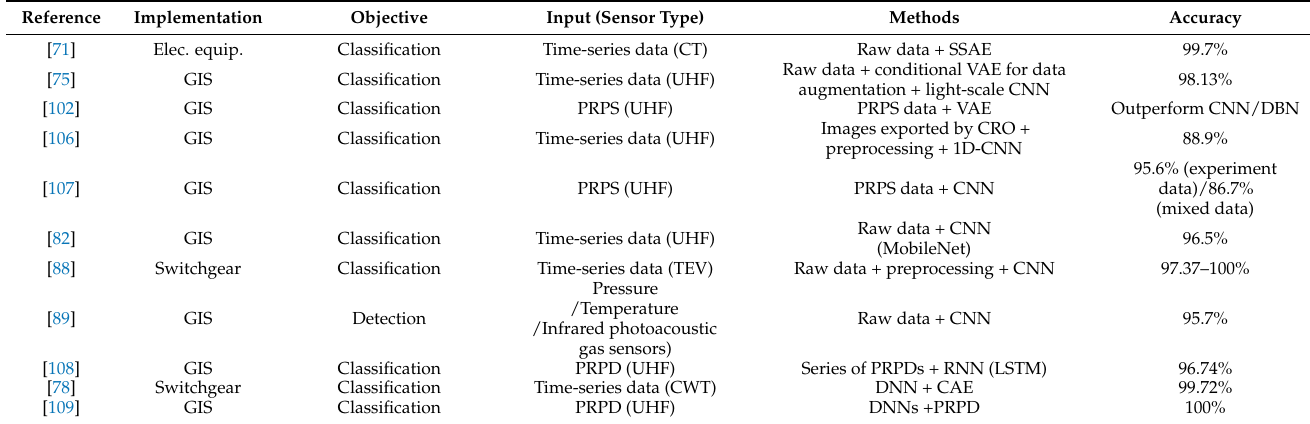
Table 5. Summary of DL